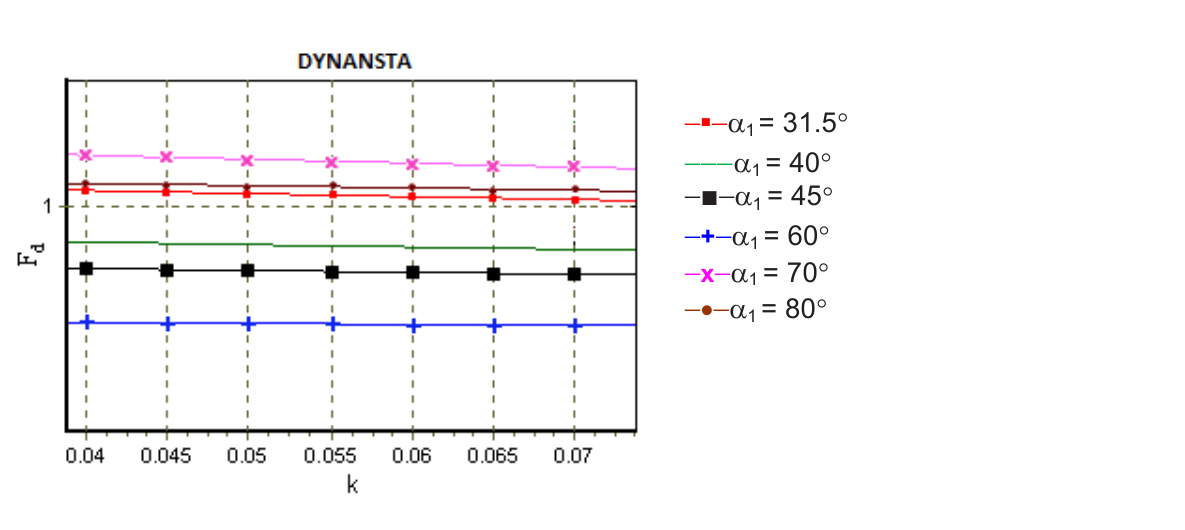
Figure 10: Effect of the slope angle with PLAXIS and GEOSTAB.